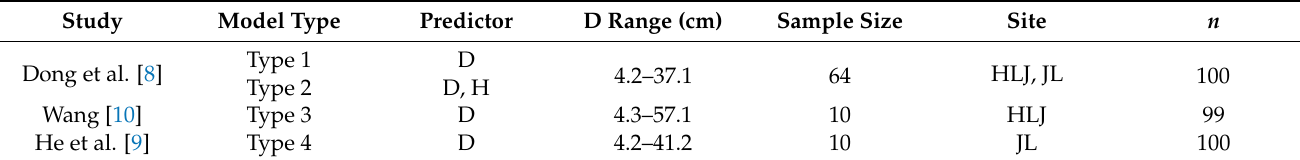
Table 2. Comparison of existing models using the measured biomass data in this